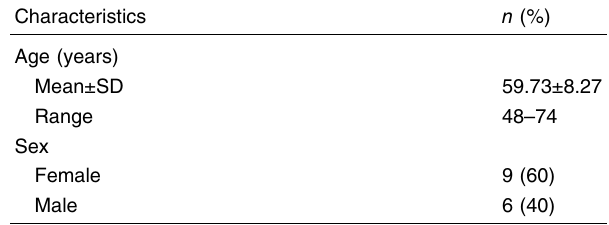
Table 1 Demographic characteristics of the studied group Characteristics